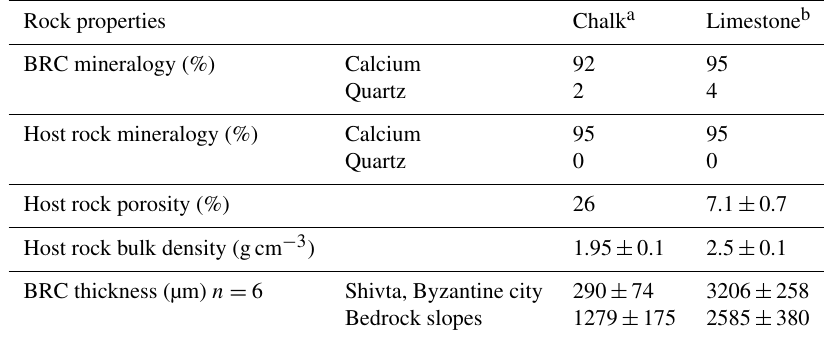
Table 1. Biological rock crust (BRC) thickness and geotechnical properties of the subjected strata (mean ± SE). Rock